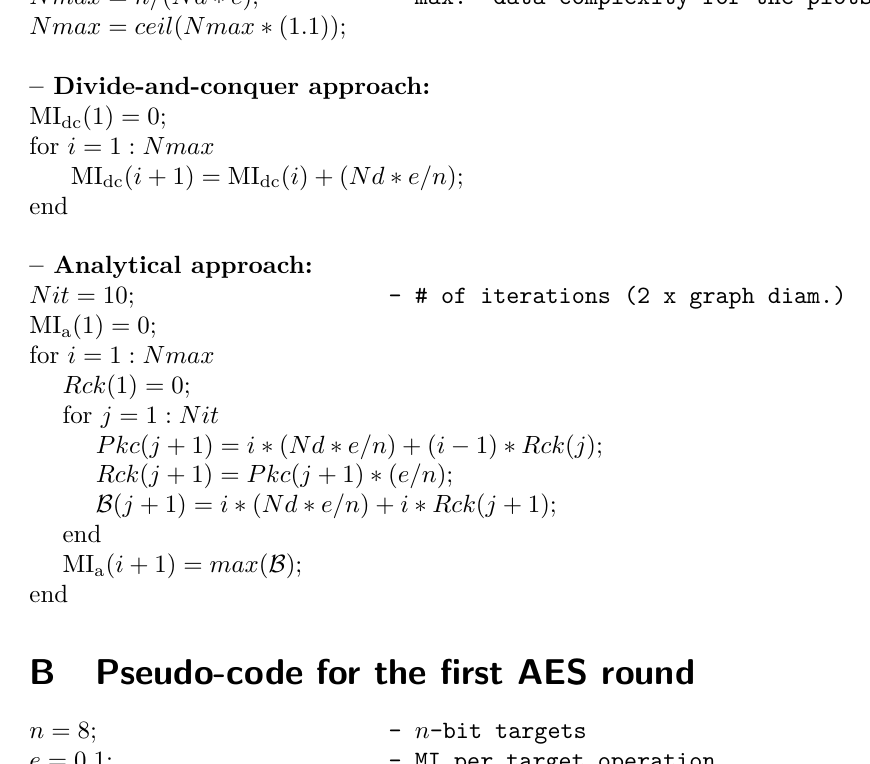
data complexity for the plots)